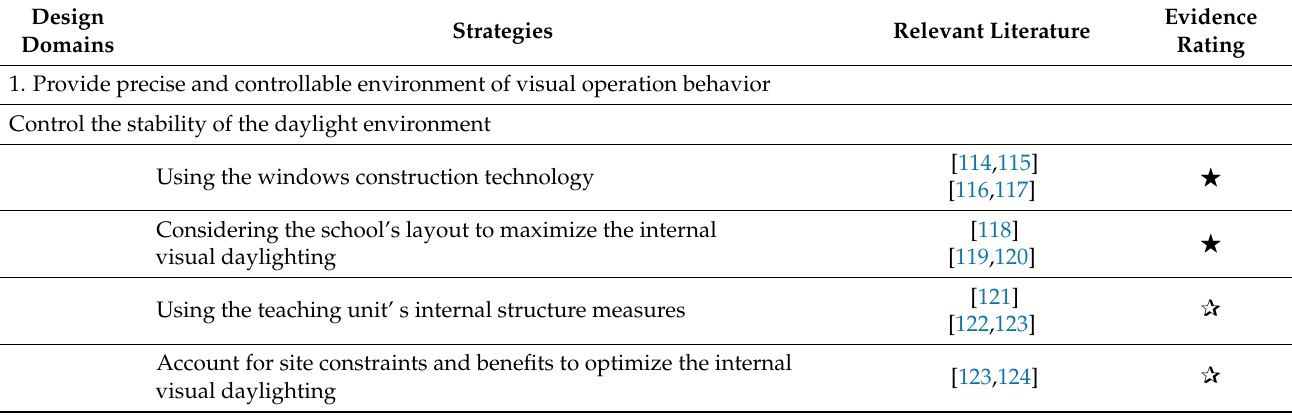
selection of background wall’s material and color collocation